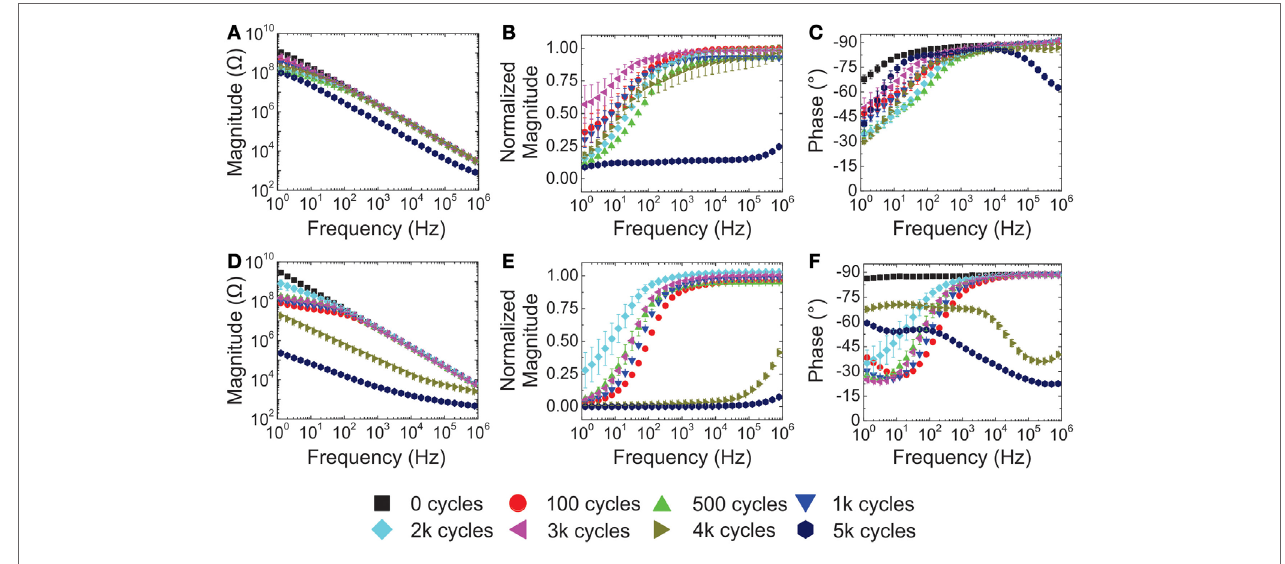
represented by downward shifts in magnitude (a,D) emphasized by normalizing the data to the impedance magnitude at 0 bends (B,e) , and shifts in phase (c,F) at high and low frequencies (mean ± SE, n =